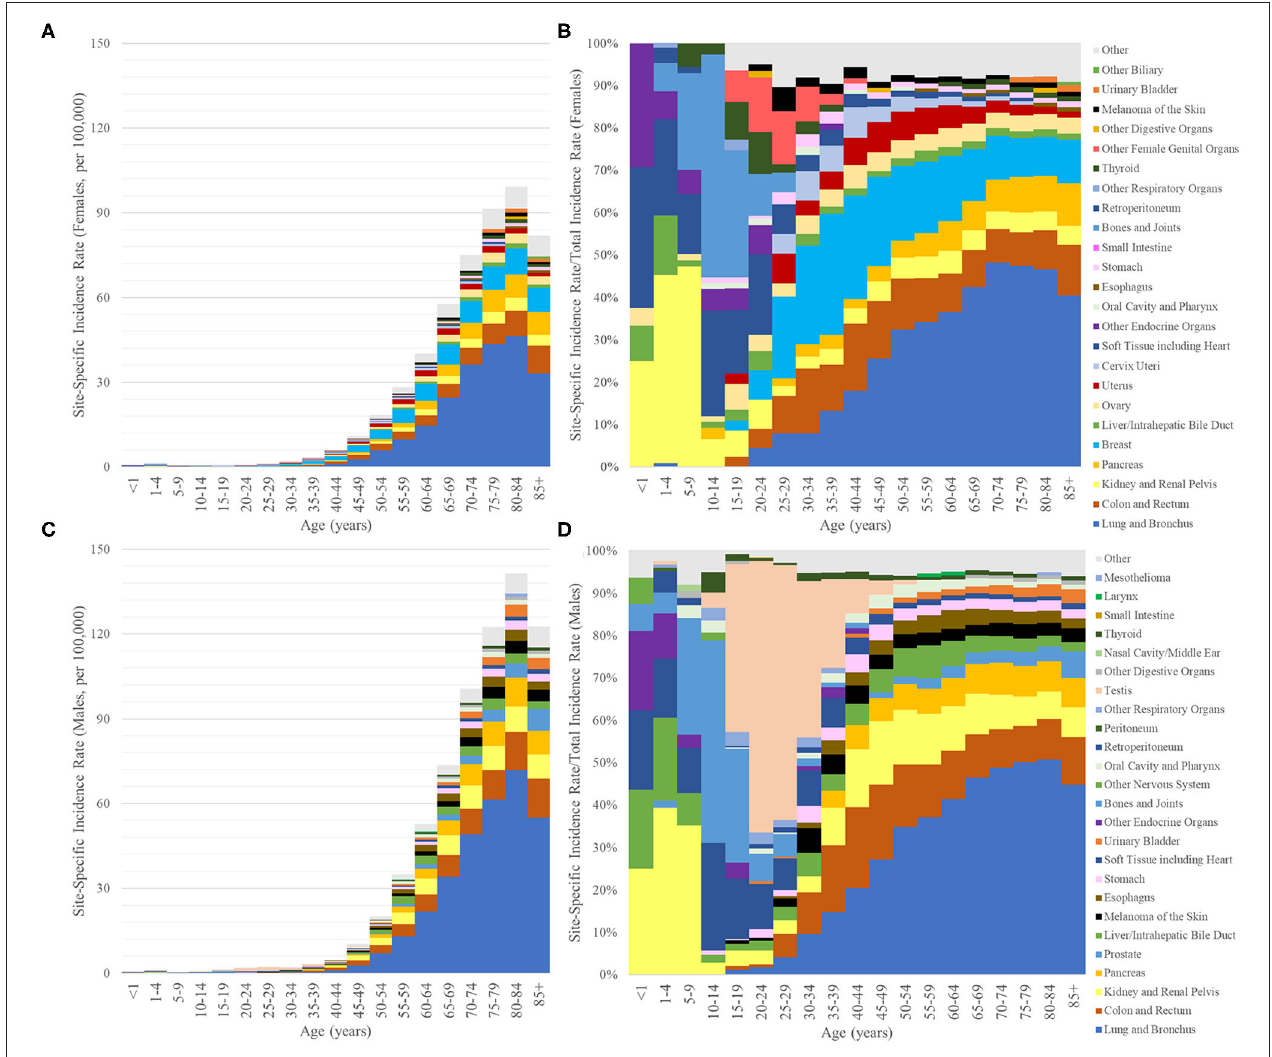
FIGURE 2 | Bar graphs of the incidence rates per 100,000 of synchronous lung metastasis (y-axis) vs. age at diagnosis (x-axis, 5-year bins) broken down by primary sites of origin, which are indicated by different colors (only the top 10 for ages < 15 and top 15 for ages > 15). (A,B) Female. (C,D) Male. (A,C) y-axis values represent absolute incidence rates. (B,D) y-axis values represent the percentage of synchronous lung metastasis from one primary site relative to the overall incidence of synchronous lung metastasis from all primary sites for that age group.